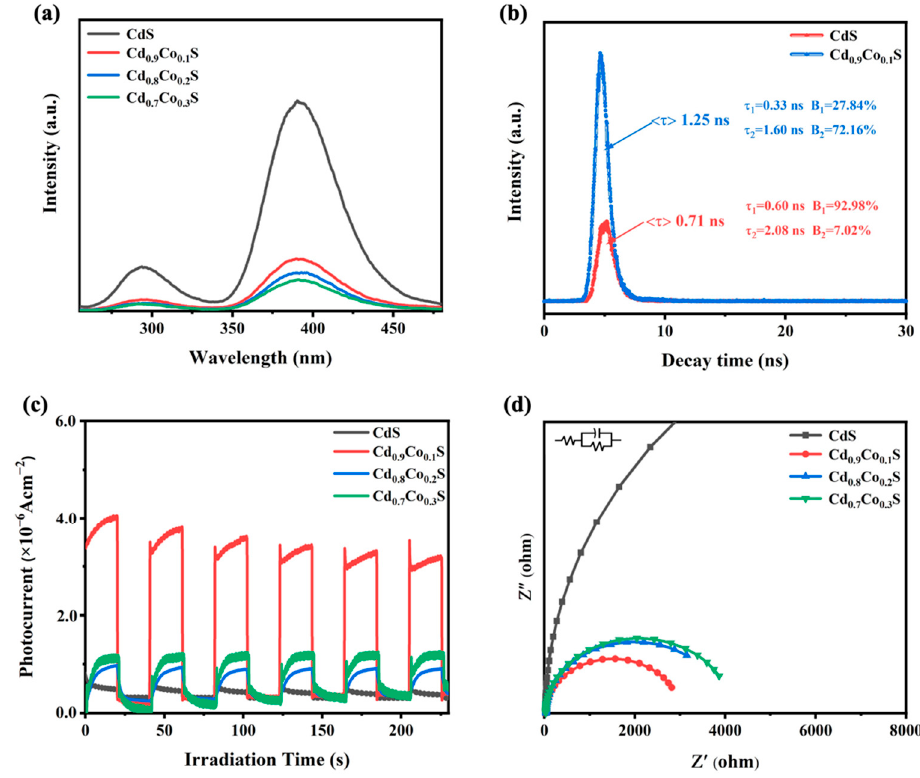
Figure 7. PL spectra ( a ), TRPL decay spectra ( b ), photocurrent responses ( c ), and EIS plots ( d ) of as-prepared samples.